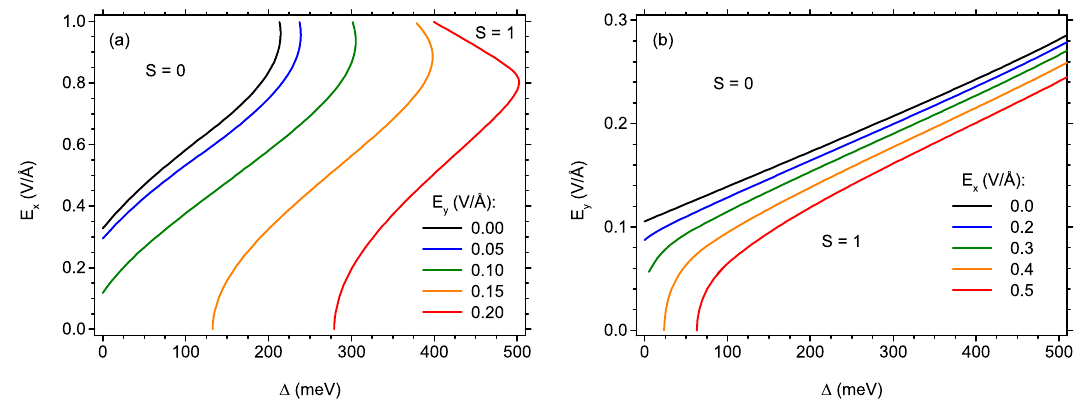
Figure 4. The phase diagram showing the borders between the state with S = 1 and the state with S = 0 as a function of the exchange energy and electric field along the x -direction ( a ) and along the y -direction ( b ), for various values of electric field along the other